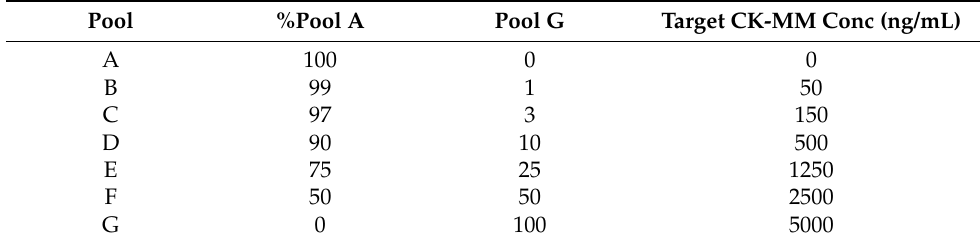
Table 1. Admixtures of Pool A (base pool) and Pool G (CK-MM spiked pool) in Pools B–F.